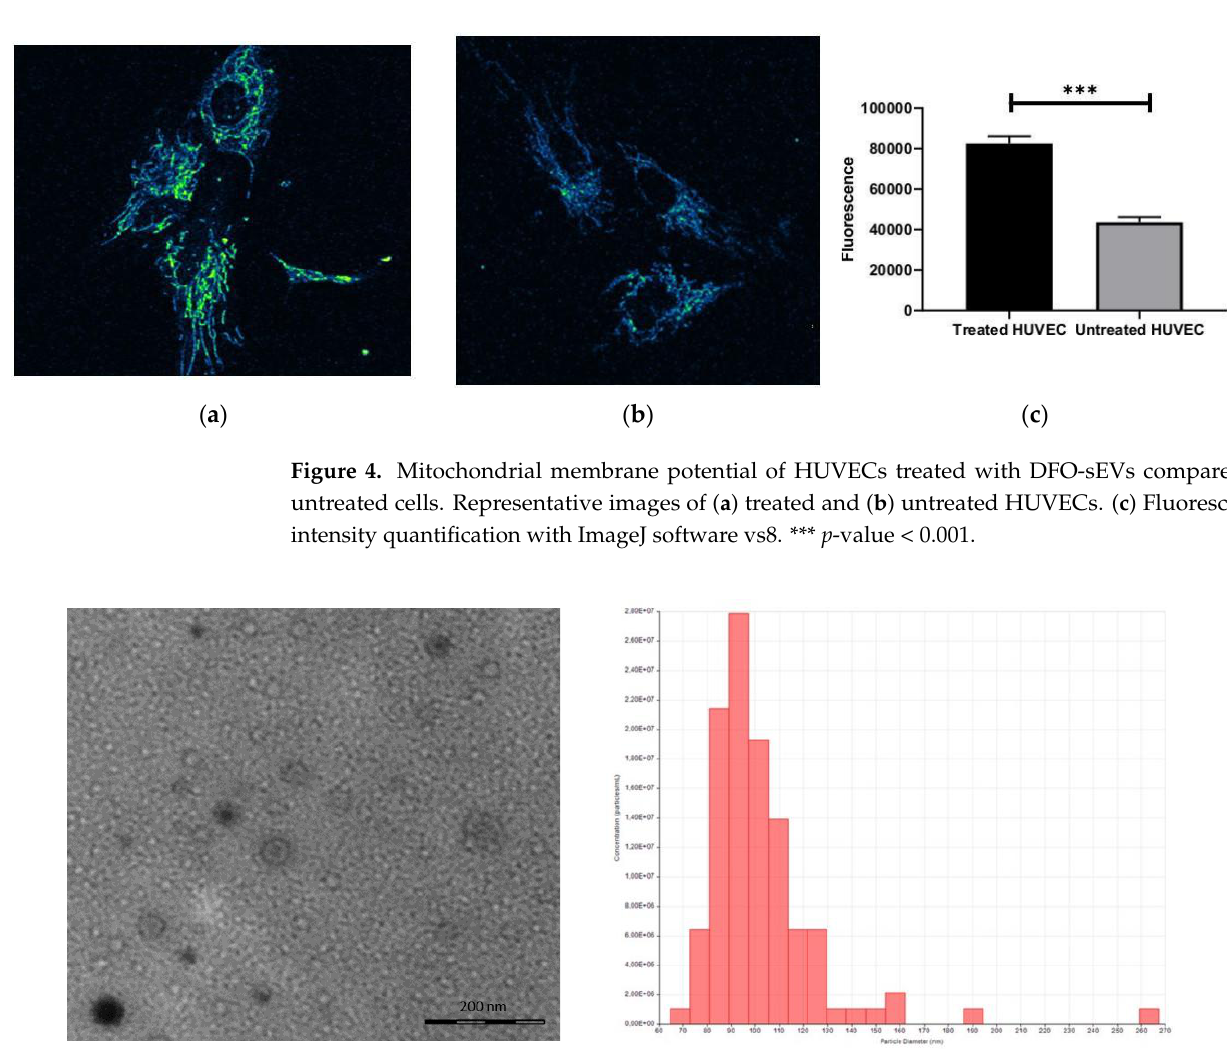
Figure 3. Functional enrichment analysis with FunRich software version 3. ( a ) Pie chart of cellular component enrichment. ( b ) Biological pathway enrichment. ( c ) Biological process enrichment. Percentage of genes involved in each function (blue bar), p -value (red bar), and reference (orange bar).